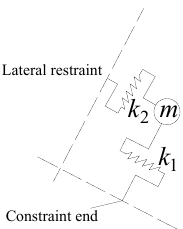
Figure 3. Dynamic model diagram of a single degree of freedom structure of a reverse dip rock.